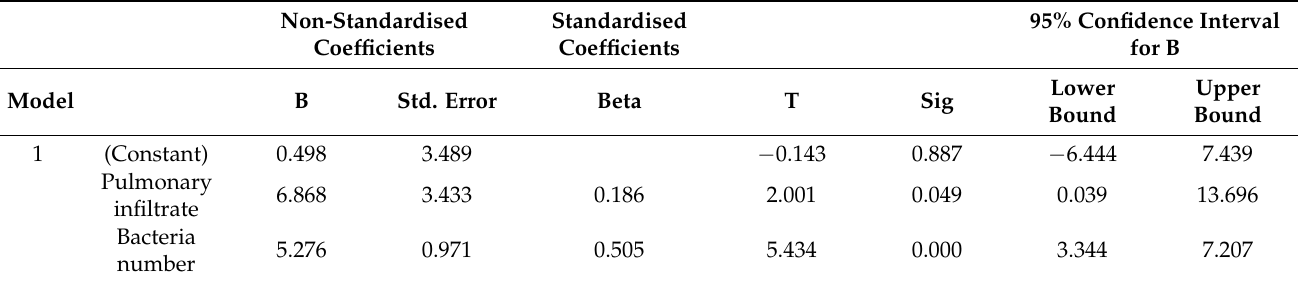
Table A6. Coefficients